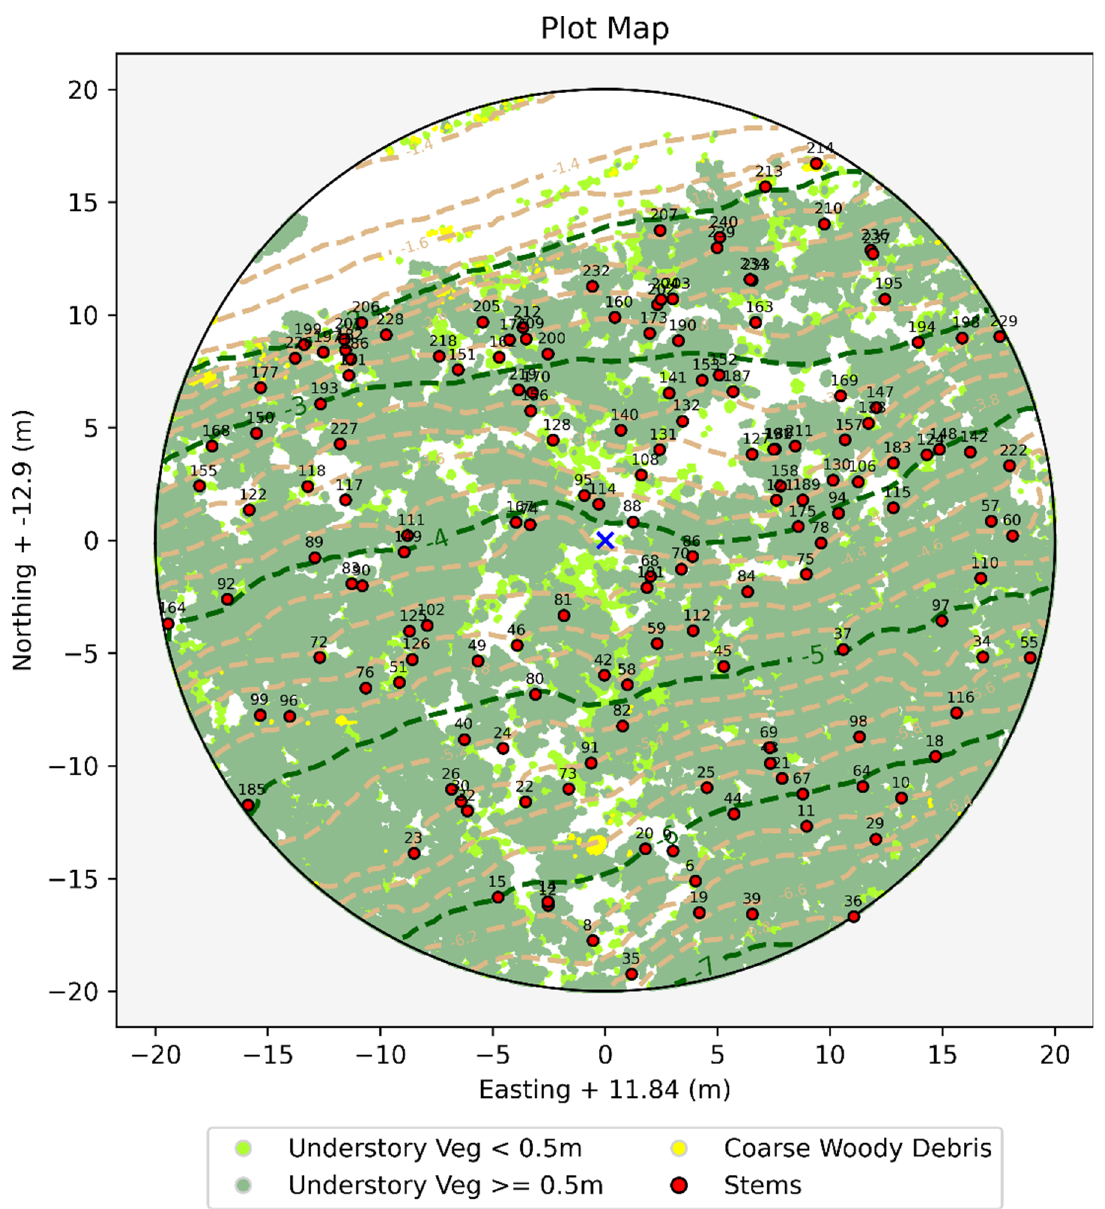
Figure 10. One of the outputs of FSCT is a plot map showing coarse woody debris, understory vegetation, contours of the terrain, and the locations of the stems. There is a dirt road at the top of the figure, which is seen by the lack of understory vegetation.